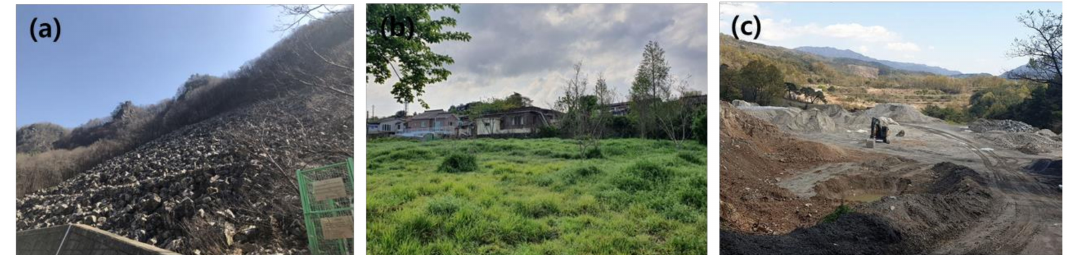
Figure 6. Examples of areas excluded from the damaged areas: ( a ) The area identified as talus in Gangwon-do; ( b ) the area where grassland was established in Gyeongsangnam-do; ( c ) the area where development is in progress in